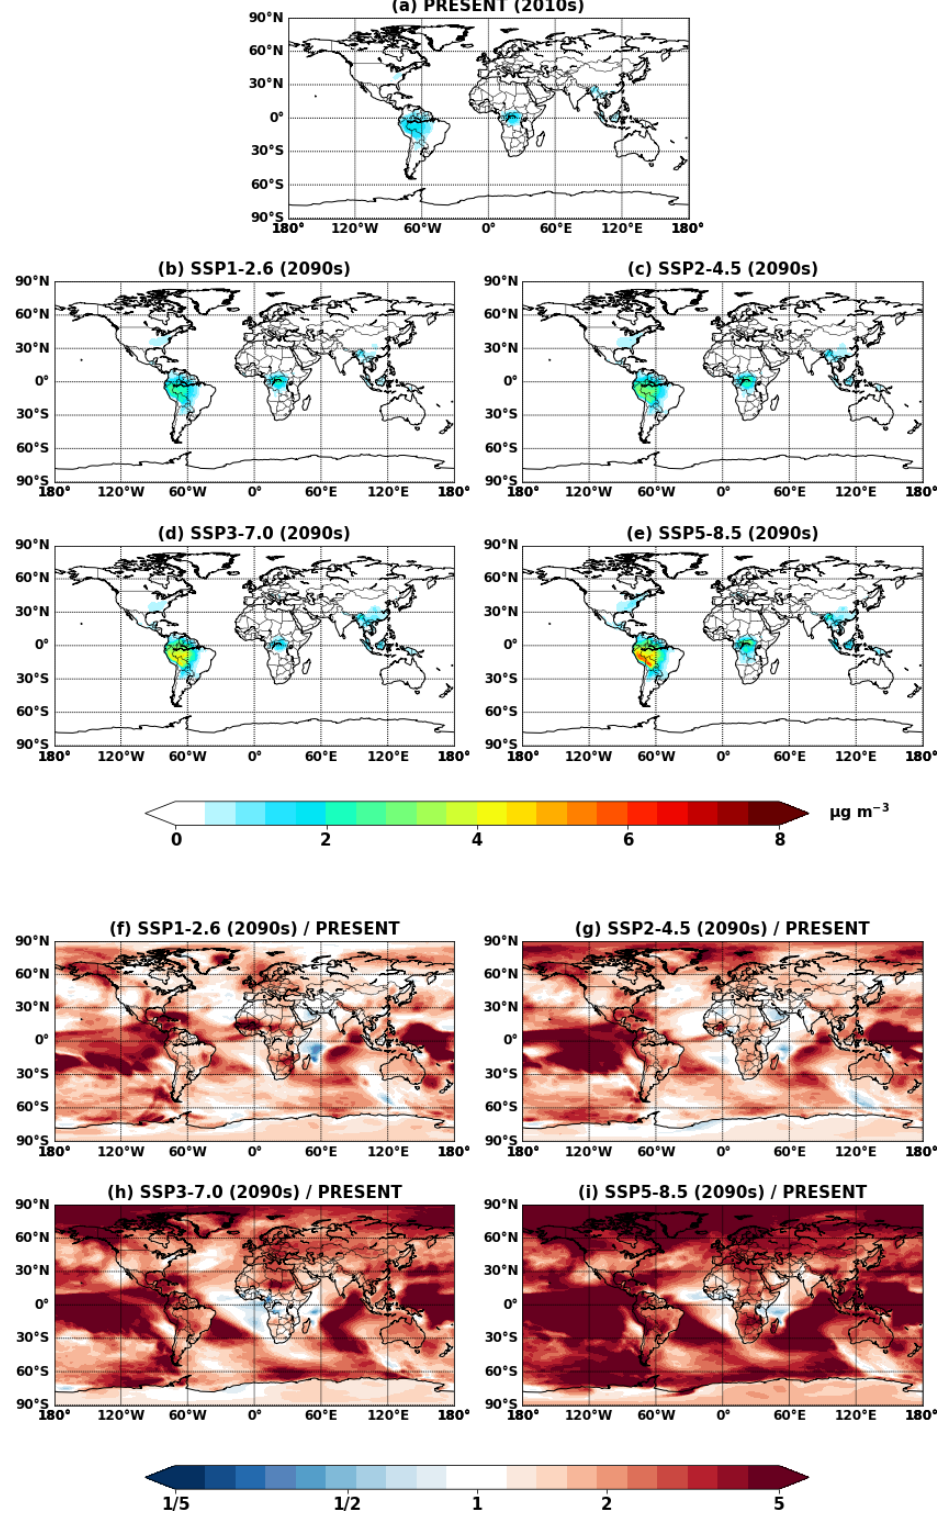
Figure 11. Global mean isoprene SOA concentrations at the surface simulated in (a) VBS_2010 and (b–e) VBS_2090_SSPx. (f–i) Ratios of isoprene SOA between future (b–e) and present (a)